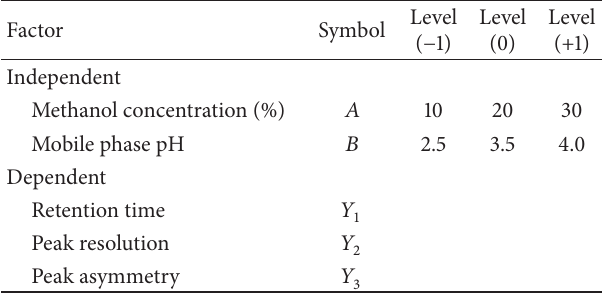
Table 1: Independent variables, dependent variables, and levels of the face centered central composite